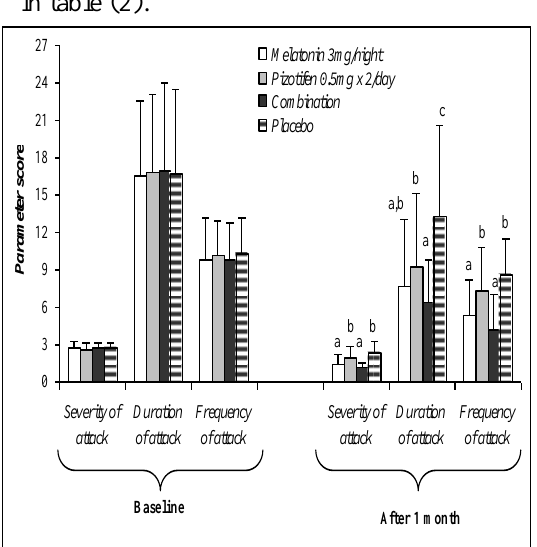
Fig (2): Migraine parameters before and after 1 month treatment with melatonin (3mg/night), pizotifen (0.5mg x2/day), their combination and placebo. Data are expressed as mean ± SD, n=18 per group. All parameters are significantly different with respect to their baseline value (P<0.05, by Paired Student’s t-test). Non identical superscripts (a, b) within the same parameter considered significantly different (P<0.05, by Unpaired Student’s t